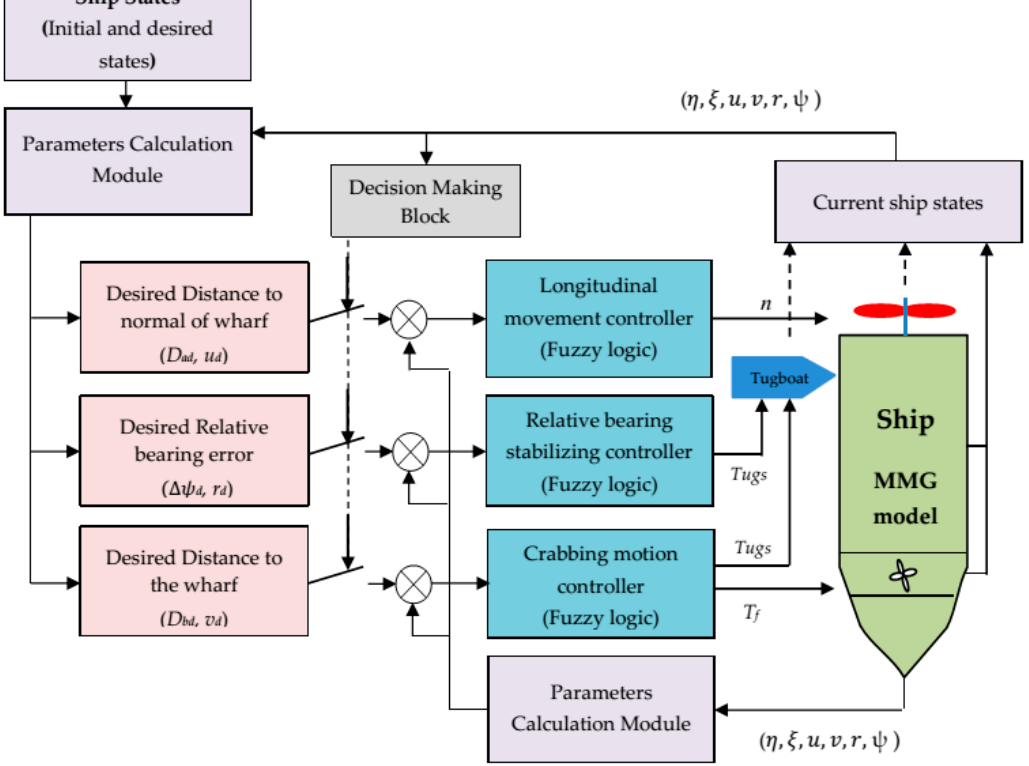
Figure 5. Block diagram of a support system for automatic ship berthing.